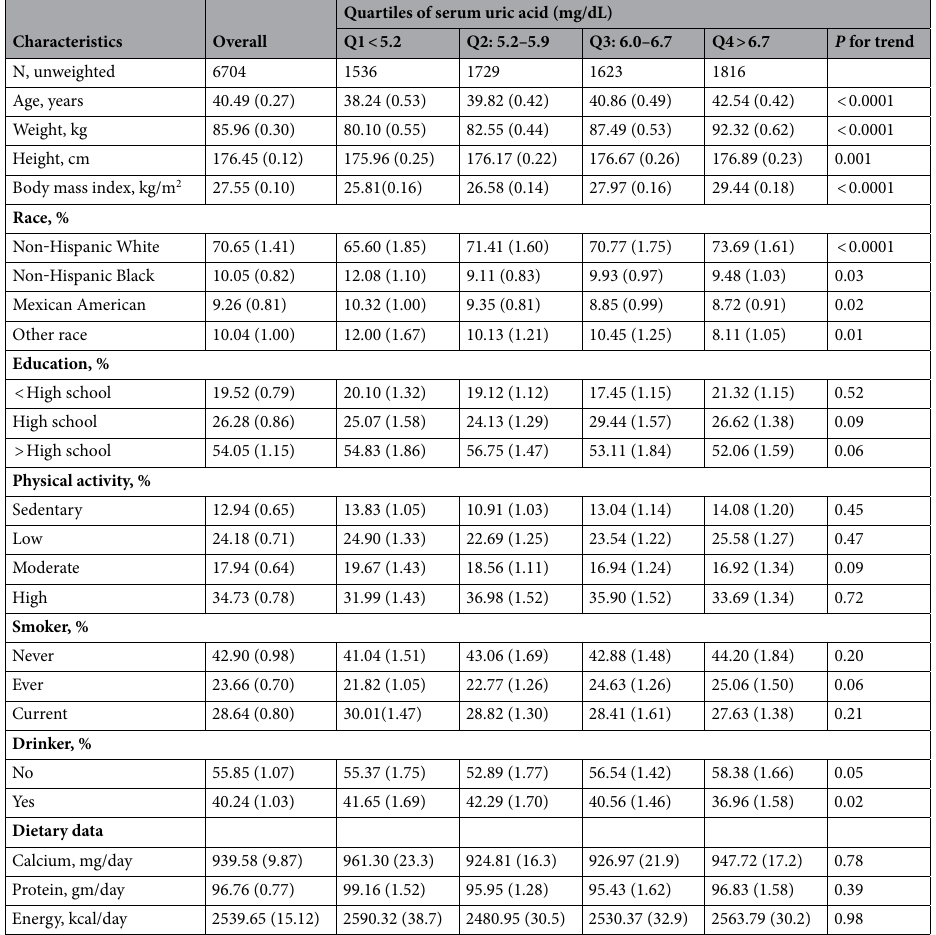
Table 1. Socidemograophic and dietary characteristics of study population based on Serum Uric Acid quartile, weighted. Data are expressed as weighted means (standard error, Se) or proportions (Se).